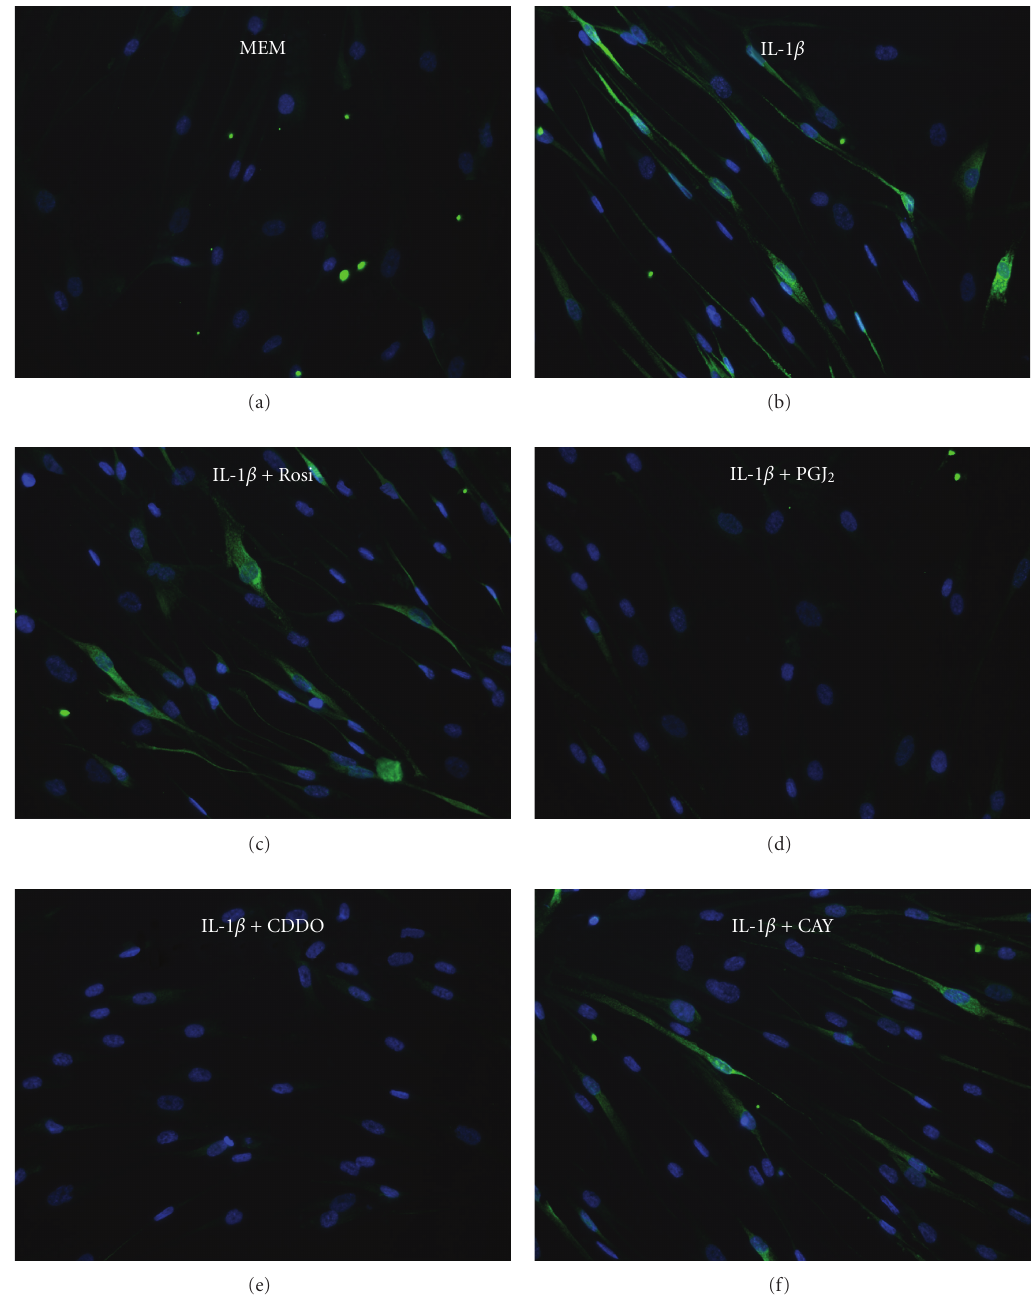
Figure 4: Immunofluorescence of human lung fibroblasts demonstrates CDDO and 15d-PGJ 2 attenuate IL-1 β -induced COX-2 expression. Fibroblasts were pretreated with PPAR γ agonists for 1 hour prior to IL-1 β (1ng/mL) treatment for 24 hours. Cells were fixed and permeabilized and probed for COX-2 protein. COX-2 was visualized with Alexa Fluor 488 (green) and cell nuclei with DAPI (blue). (a) MEM control; (b) IL-1 β ; (c) IL-1 β + 20 μ M rosiglitazone; (d) IL-1 β + 1 μ M CDDO; (e) IL-1 β + 5 μ M 15d-PGJ 2 , (f) IL-1 β + 5 μ M